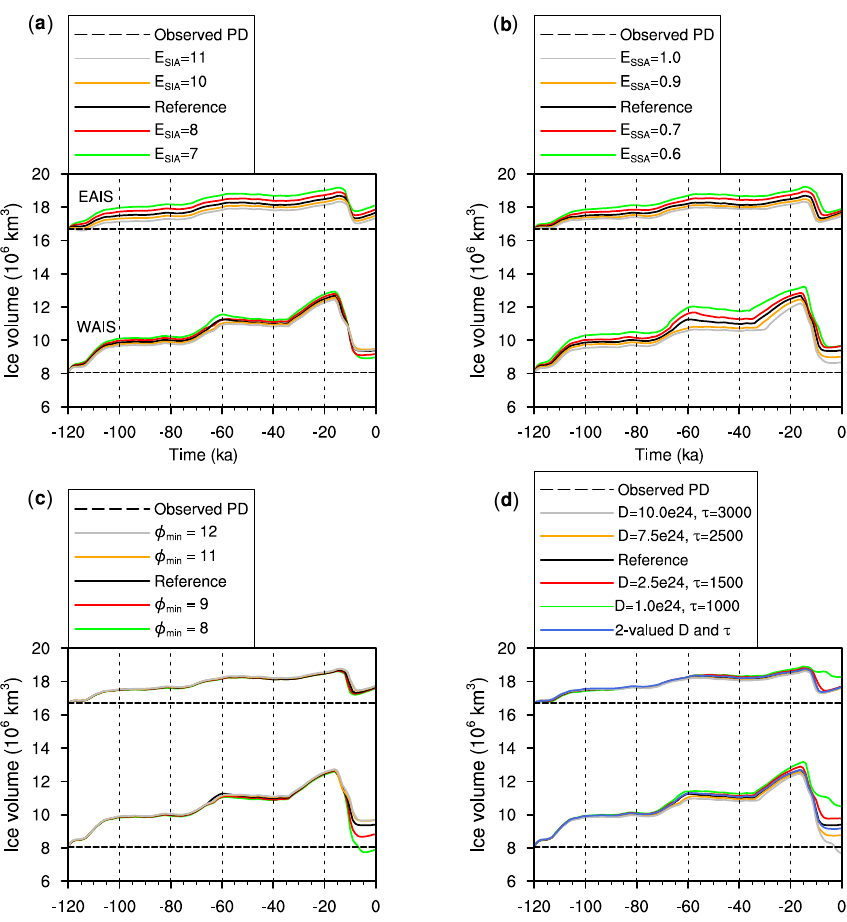
Figure 9. EAIS (upper lines) and WAIS (lower lines) grounded ice volume from 120ka until the present for different values of the (a) SIA enhancement factor ( E SIA ), (b) SSA enhancement factor ( E SSA ), (c) sliding parameter φ min and (d) flexural rigidity ( D ) and relaxation time ( τ ), with an extra blue line indicating the simulation with D = 5 . 0 × 10 24 Nm, τ = 2000yr for the WAIS and D = 1 . 0 × 10 25 Nm, τ = 3000yr for the EAIS. The reference simulation (black solid line) has E SIA = 9, E SSA = 0 . 8, φ min = 10 ◦ , D = 5 × 10 24 Nm and τ = 2000yr. Dashed lines have been drawn in black at the level of the PD grounded ice volume for both the EAIS and the